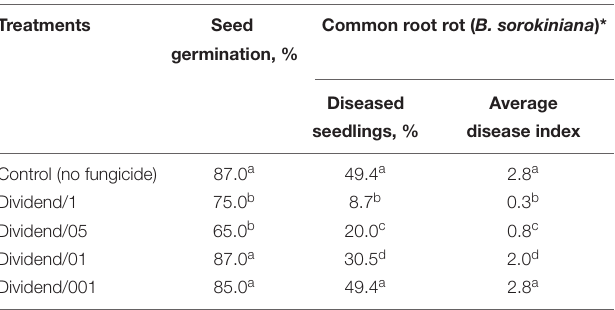
TABLE 4 | Development of B. sorokiniana on barley seedlings grown from naturally infected seeds treated with Dividend R (cid:13) 030